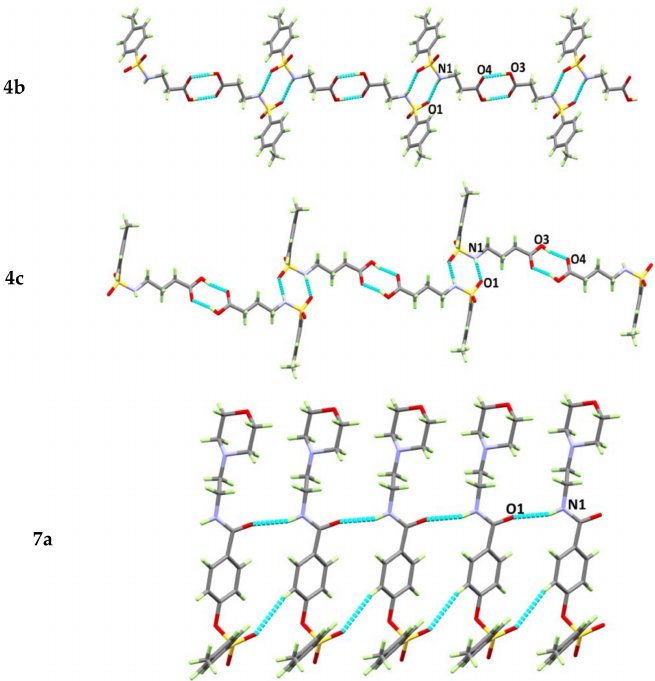
Figure 2. Hydrogen bond polymers of 4b , 4c and 7a